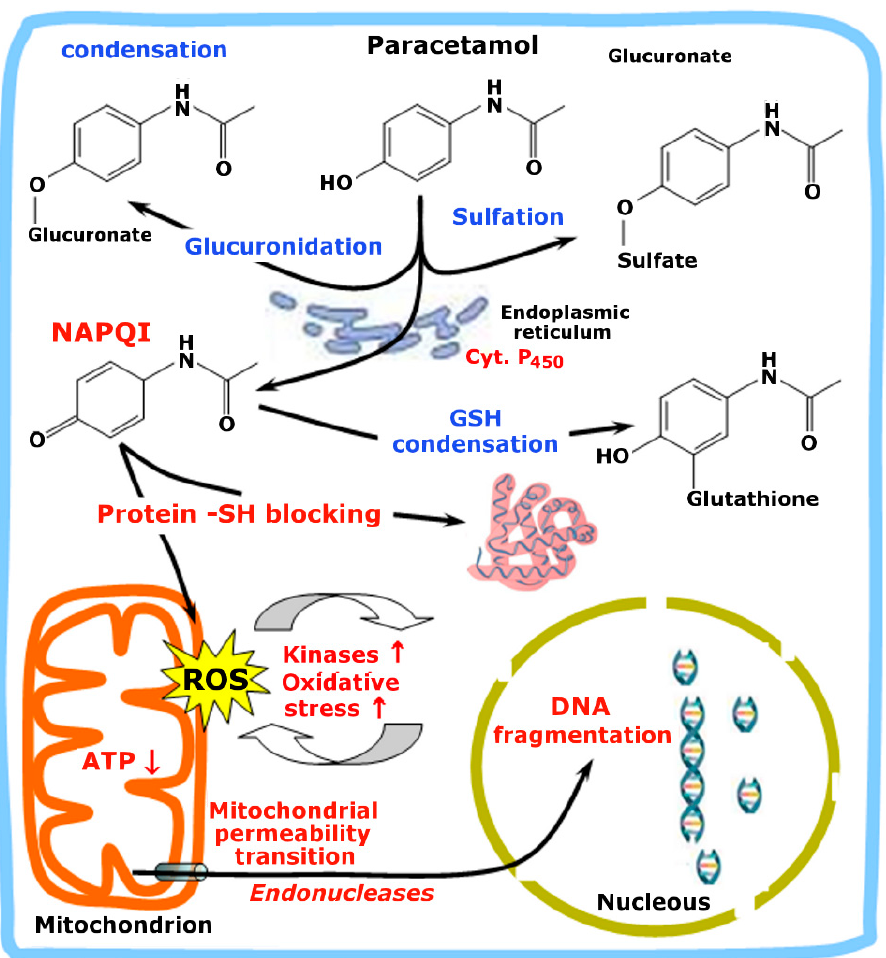
Figure 2. Main events of the paracetamol-induced liver injury. Upward arrows mean increase; downward ones mean decrease. NAPQI means N-acetyl-p-benzoquinone imine. A more detailed description can be found in the text.